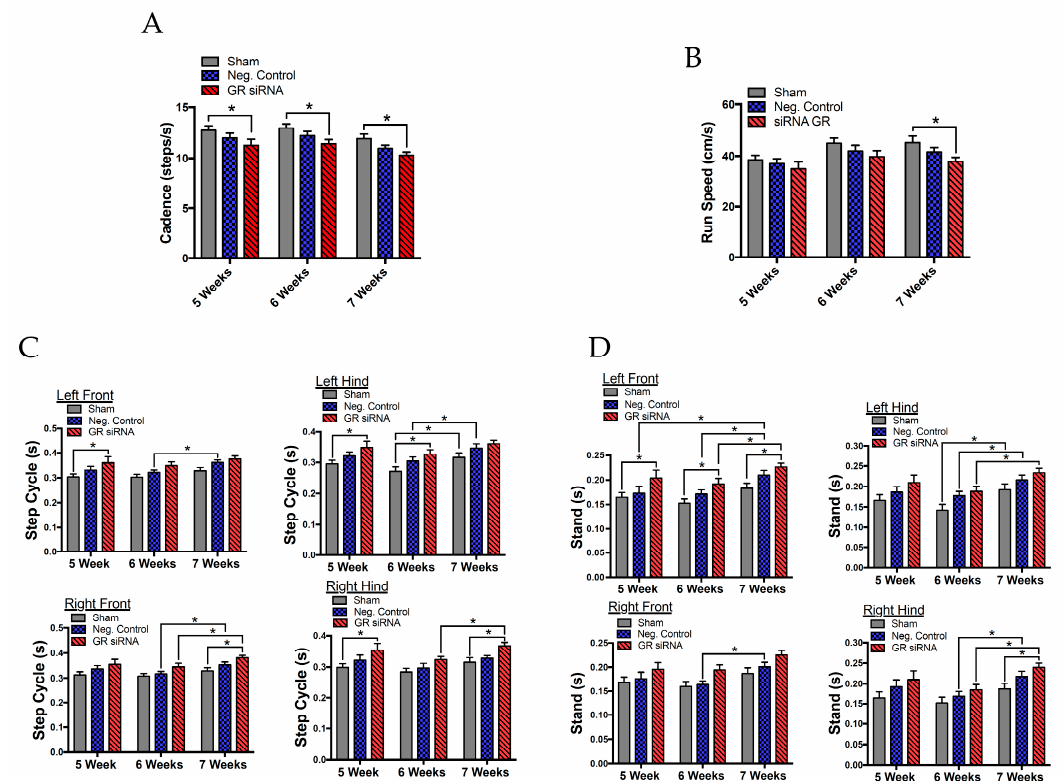
Figure 6. Repression of GR worsens long-term neurobehavioral deficits in the neonatal male rat with mild HI injury. The neonatal male rats received GR siRNA (100 pmol) or negative control (100 pmol) by ICV injection 48 h before HI-injury (8% FiO 2 ; 60 min). Groups were sham (negative control; ( n = 12) versus negative control with HI injury ( n = 13) versus GR siRNA ( n = 11) with HI injury. Catwalk test was performed at five, six, and seven weeks after HI injury for ( A ) cadence, ( B ) run speed, ( C ) step cycle duration, and ( D ) stand duration. Data are means ± SEM, * p < 0.05.